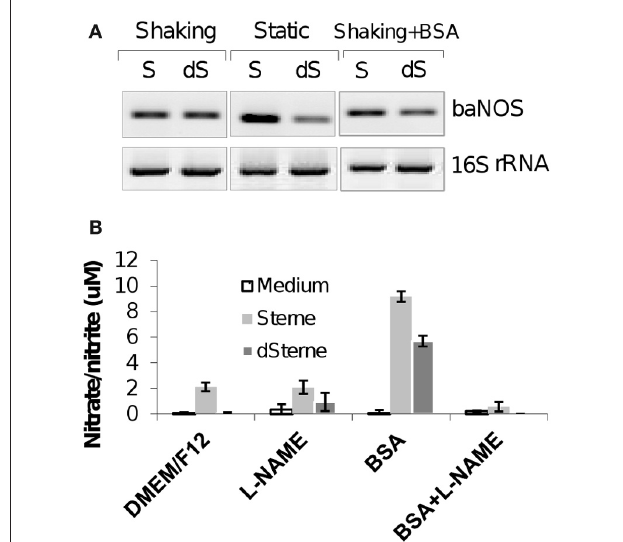
FIGURE 1 | BaNOS is expressed in aerated and static cultures, which accumulate nitrate/nitrite as trace products of NO in the presence of BSA. (A) RT-PCR of baNOS mRNA in different culture conditions. Left and middle panels compare the aerated and static conditions. Left and right